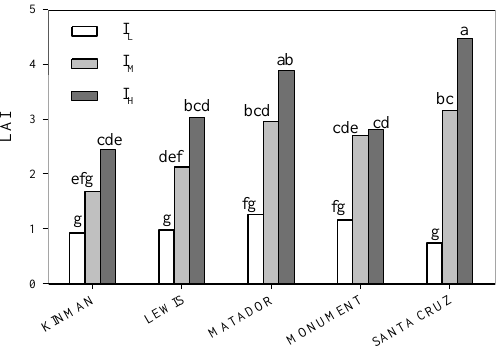
Figure 7. Leaf area index in response to three levels of irrigation among five guar cultivars over two years. Bars with di ff erent letters di ff er for p <